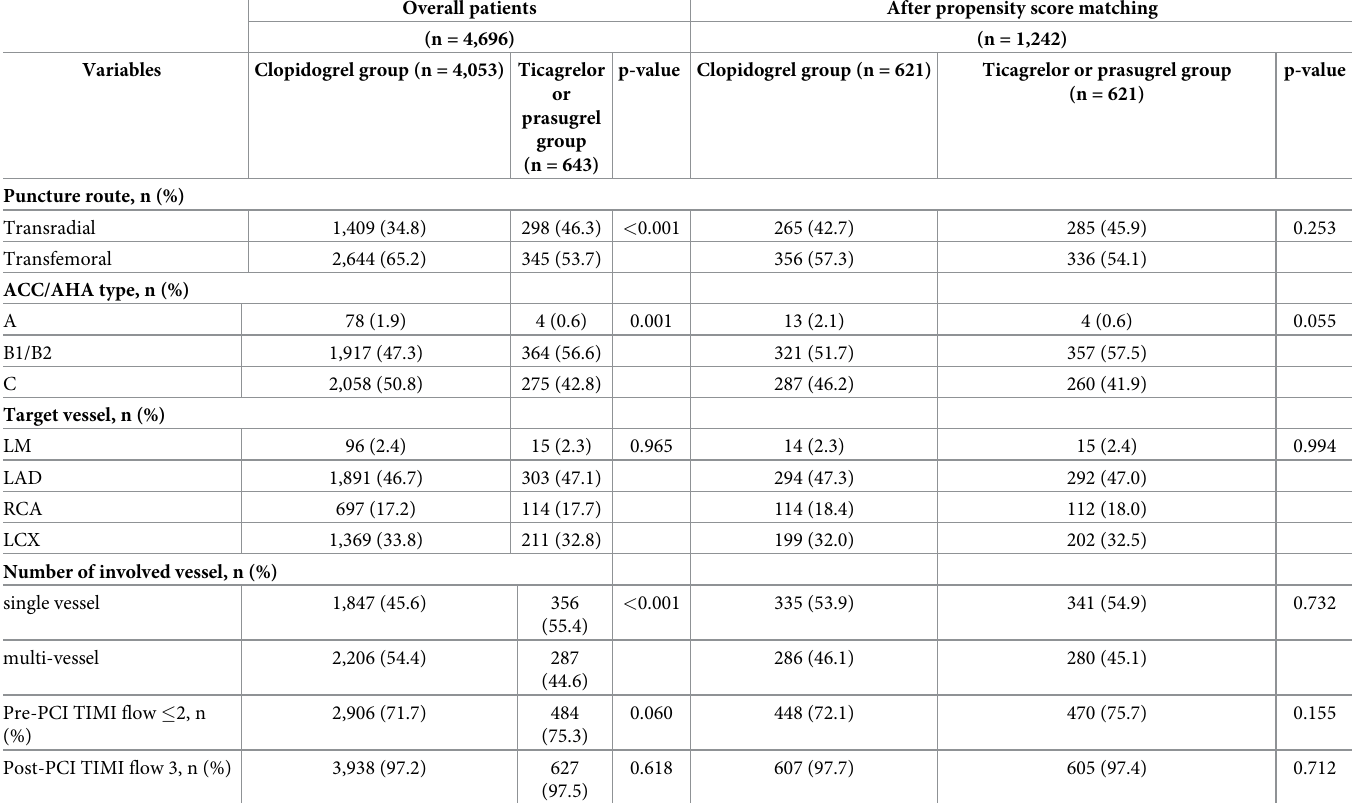
Table 2. Coronary angiographic findings and procedural characteristics of the clopidogrel and ticagrelor or prasugrel groups. Overall